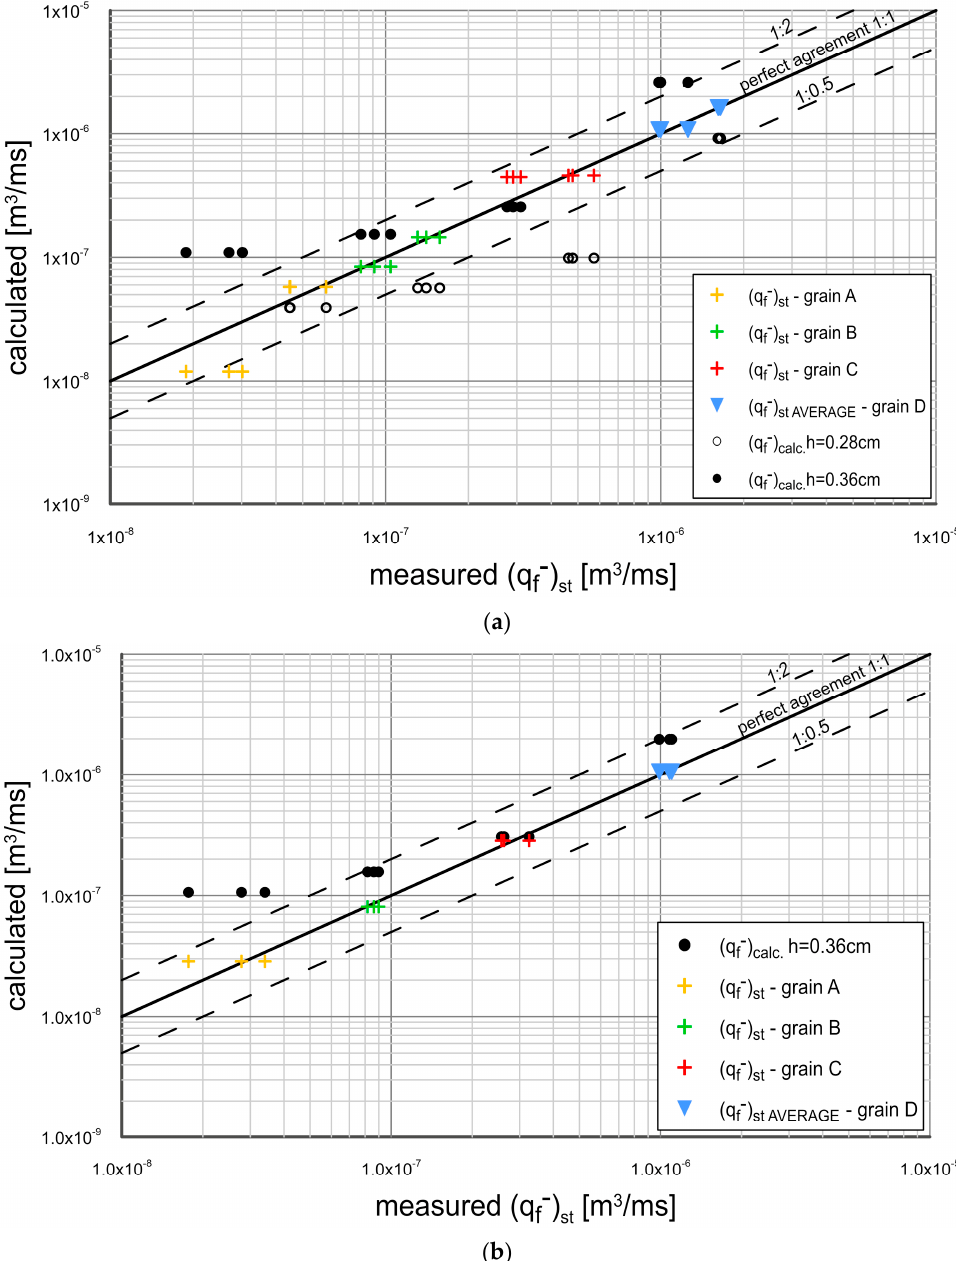
Figure 10. Comparison of calculation and measurements results q − between flat ( a ) and sloped bed ( b ) cases during the trough.